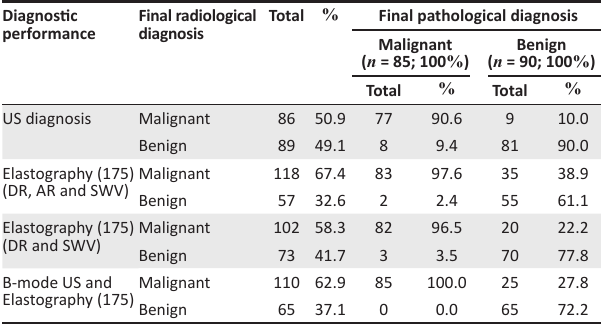
diagnosis of benign and malignant breast lesions. Diagnostic performance